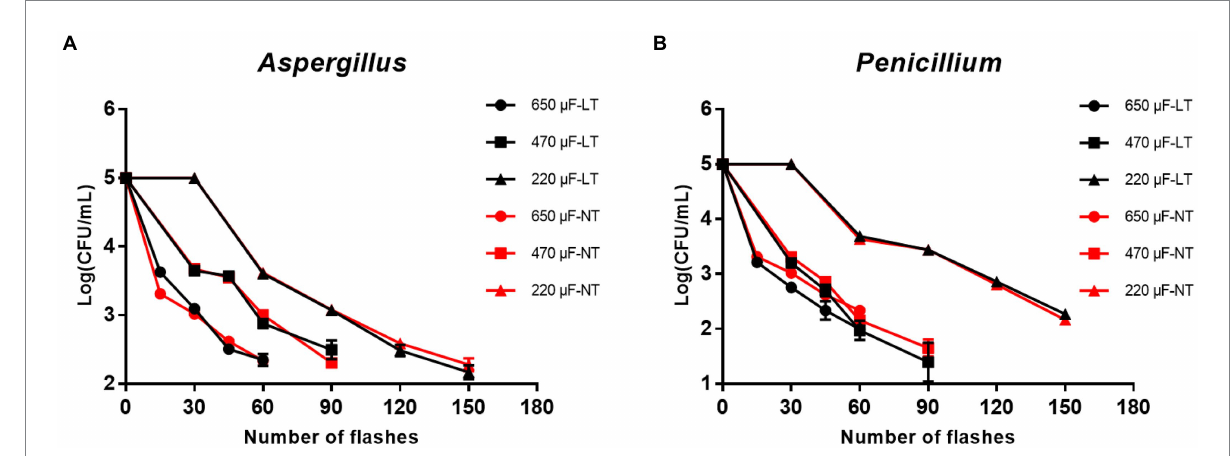
FIGURE 1 Reduction in cultivable number of Aspergillus niger and Penicillium glaucum in planktonic cultures. (A) Reduction in cultivable number of A. niger . (B) Reduction in cultivable number of P. glaucum [650, 470, and 220 μ F are three different capacitances of IPL. LT and NT mean low temperature (4 ° C) and normal temperature (25 ° C), respectively].